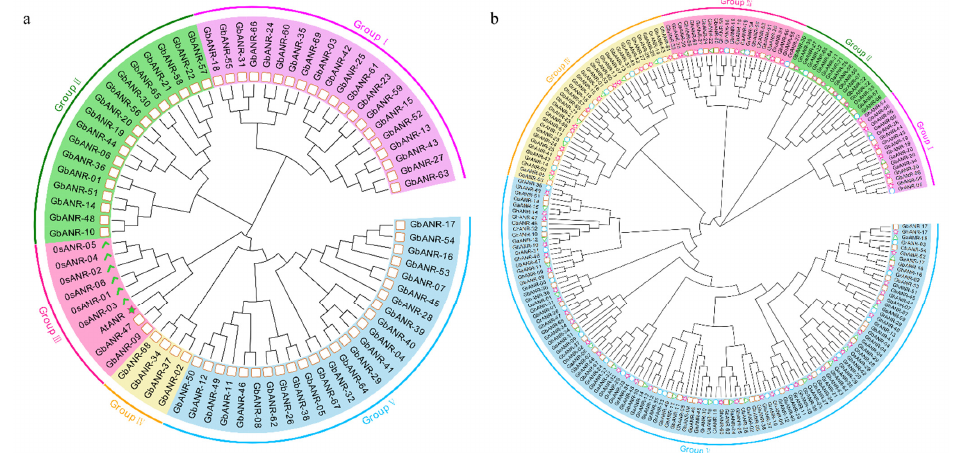
Figure 2. ( a ) Phylogenetic tree of Arabidopsis thaliana , rice, and G. barbadense . Squares represent ANR genes of G. barbadense , five-pointed stars represent ANR genes of Arabidopsis thaliana , and ticks represent ANR genes of rice. ( b ) Phylogenetic tree of G. arboreum, G. raimondii, G. hirsutum , and G. barbadense . The five-pointed star represents the ANR gene of G. hirsutum , the square represents the ANR gene of G. barbadense , the triangle represents the ANR gene of G. arboreum , and the circle represents the ANR gene of G. raimondii